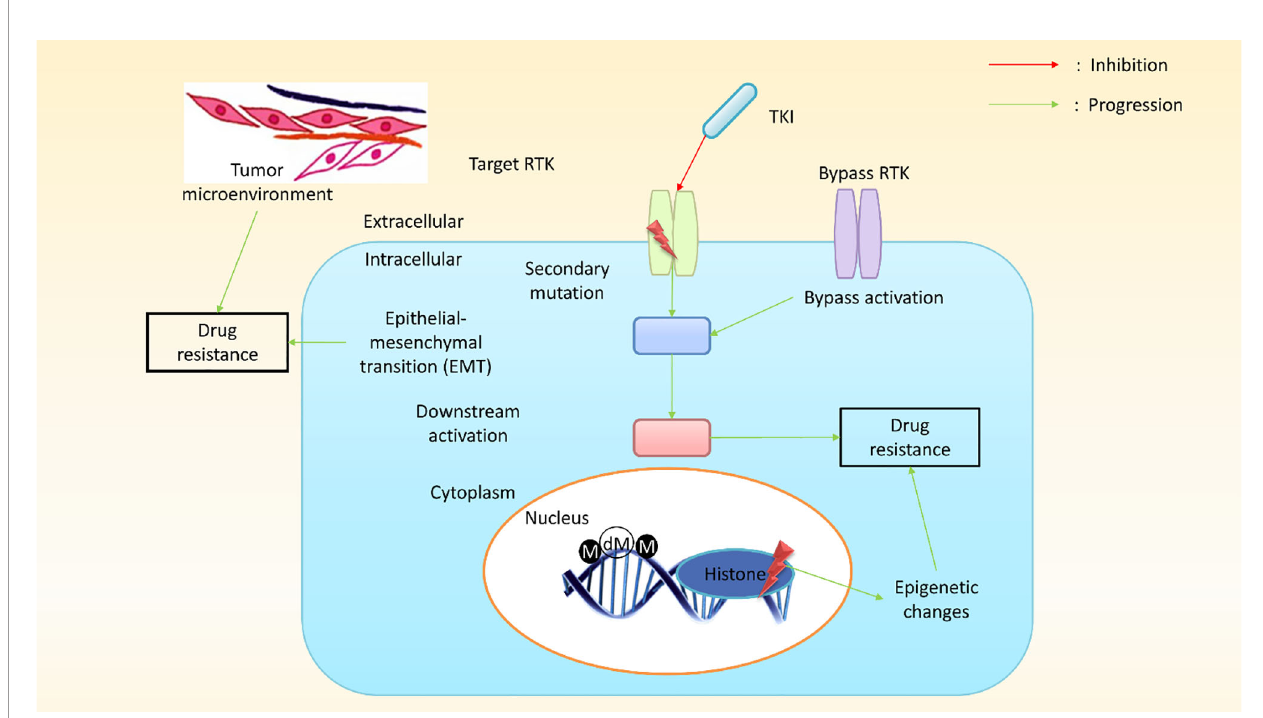
FIGURE 4 | A schematic presentation of pathway-dependent and pathway-independent drug resistance mechanisms in cancer cells. In pathway-dependent (black) mechanisms, a possible target receptor becomes activated, either through overexpression or a secondary mutation (for instance, the kinase domain and ectodomain mutation of epidermal growth factor receptor ( EGFR ) or the overexpression of a truncated version of the target receptor). In addition, gain-of-function mutations in downstream components (e.g., PIK3CA , BRAF , KRAS , etc.) or loss-of-function mutations ( PTEN , a well-known inhibitor of the downstream pathway) can proliferate downstream pathways. Other possible pathway-dependent molecular mechanisms include bypass activation, leading to the ampli fi cation of other isoforms. Pathway- independent (red) mechanisms generally involve epigenetic changes. The epithelial – mesenchymal transition (EMT) in cancer tissues and the tumor microenvironment plays a vital role in developing resistance against cancer treatment. (M, methylation; dM, demethylation; TKI, tyrosine kinase inhibitors; RTK, receptor tyrosine